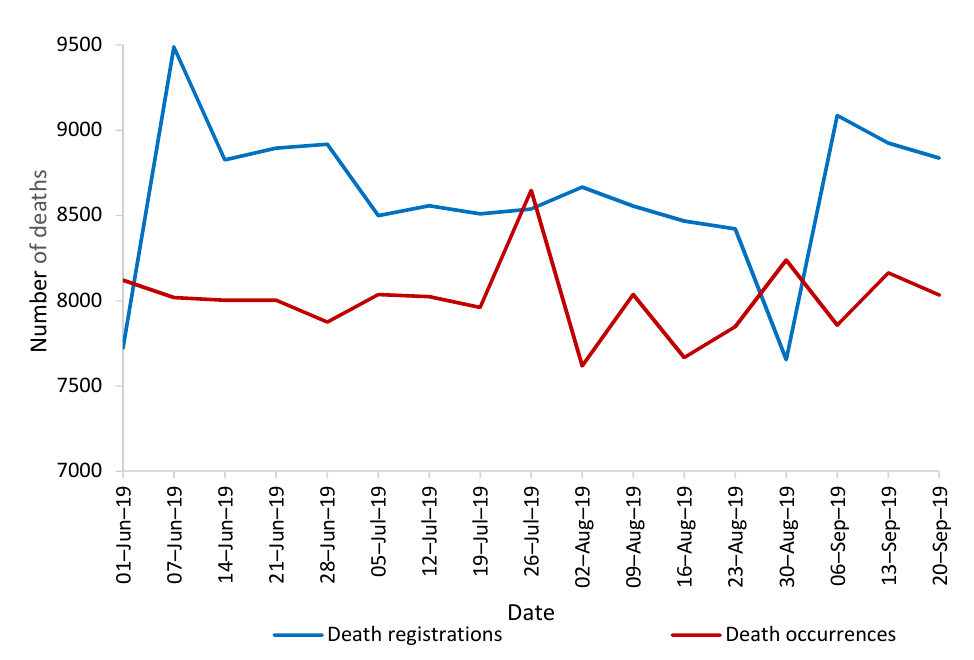
Figure 5. Daily death occurrences ( red line ) compared to death registrations ( blue line ) for the period 1 June to 15 September 2019. Table 5. Death registrations compared to death occurrences for the summer 2019 period.